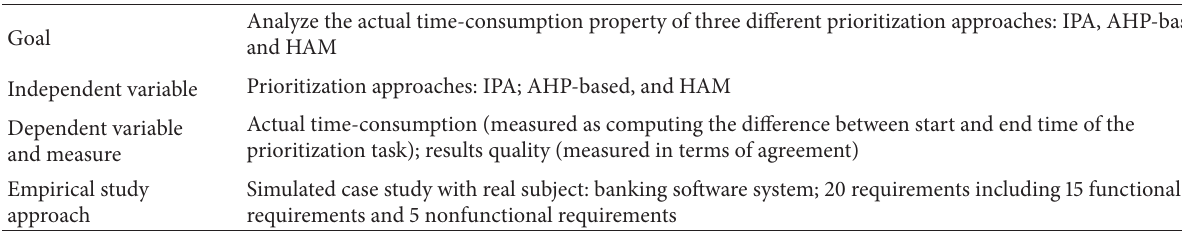
Table 6: Overview of empirical assessment performed on